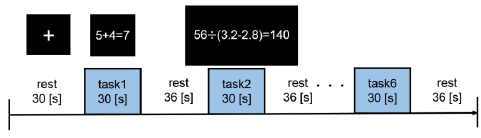
Figure 2. Experimental